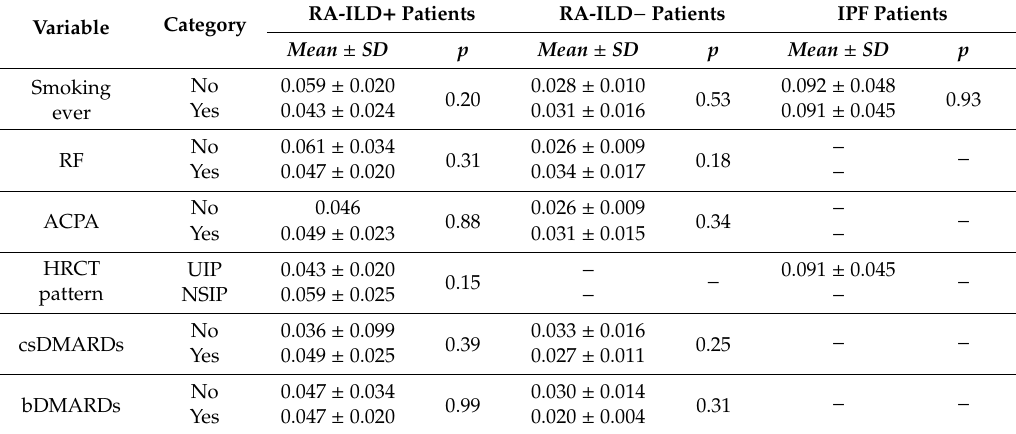
Table 3. Di ff erences in EPC frequency according to categorical variables related to disease